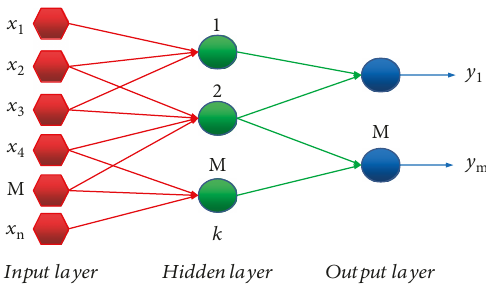
Figure 3: The structural diagram of local connection about CNN.